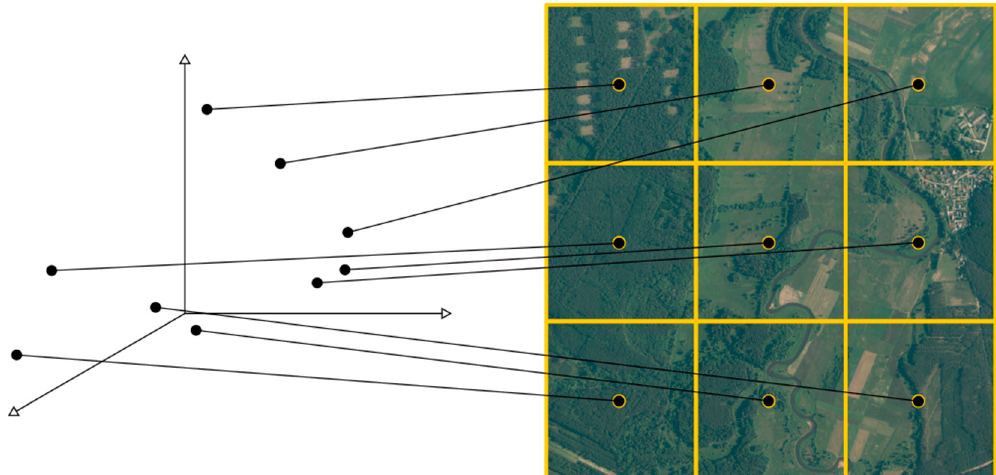
Figure 5. Latent space enhanced with geographical coordinates. The simplified image presents an example of encoding of the nine orthophoto patches (right) to a three-dimensional latent space (left) illustrated as a three-dimensional Cartesian coordinate system. Each latent code (a point in the latent space) carries additional information regarding georeferences that enables tracking its origin. Points that are closer in the three-dimensional latent space refer to patches that are visually similar. In the research, a 120-dimension latent space was trained.